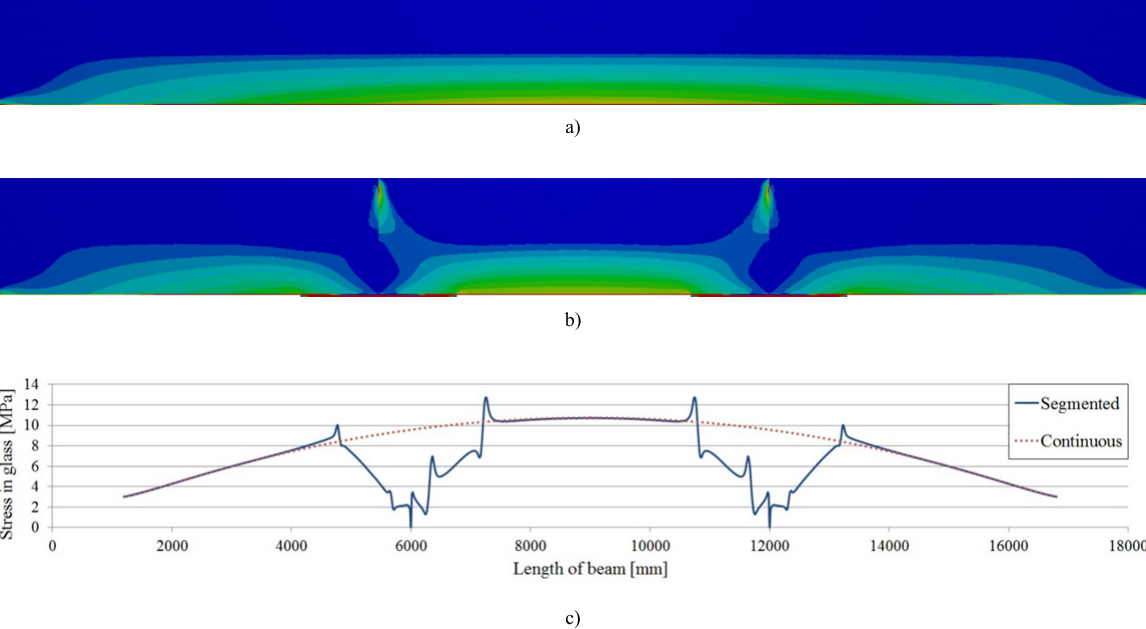
Fig: 7 Maximum principle stress in the glass, collected along a path at the bottom of both